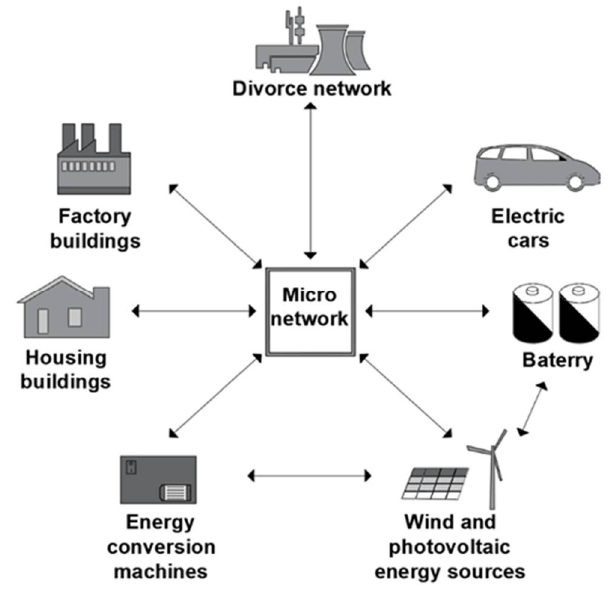
Figure 6. Microgrid connected to low voltage (LV) [37].